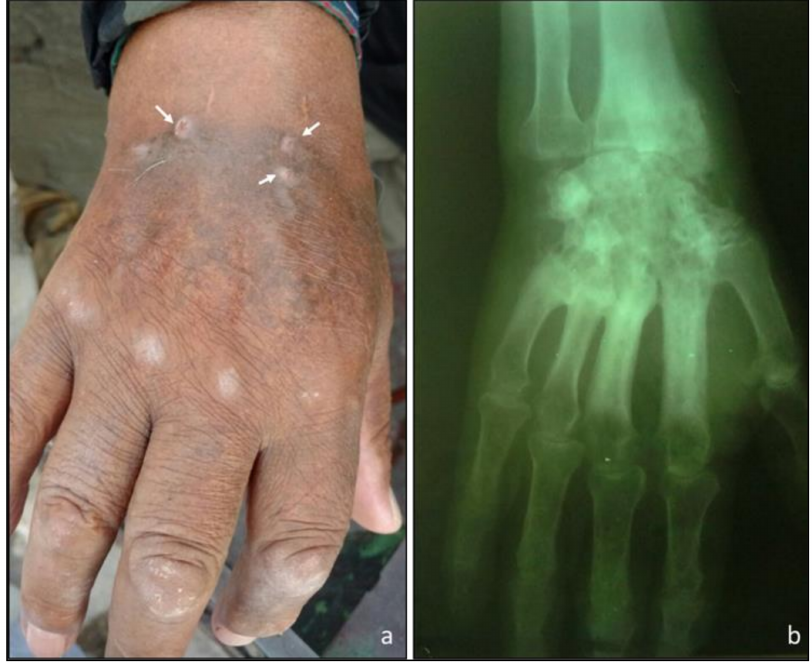
Figure 6. Subcutaneous infection of the right hand: arrows indicate drain sinuses produced in the lesion ( a ). X-ray of hand showing bone lesions ( b